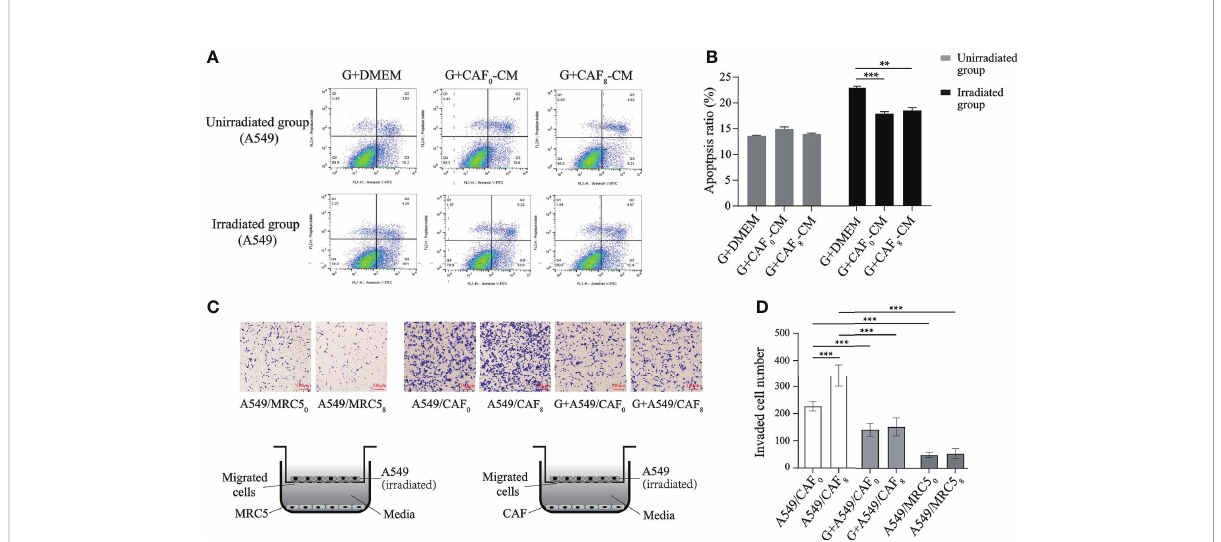
FIGURE 6 Exosome inhibitor GW4869 (G) inhibited the proliferation and migration of A549 cells induced by irradiated CAFs. (A) Flow cytometry analyzed the apoptosis of A549 cells received irradiation or not and treated with G+DMEM, G+CAF 0 -CM, and G+CAF 8 -CM. GW4869 (exosome